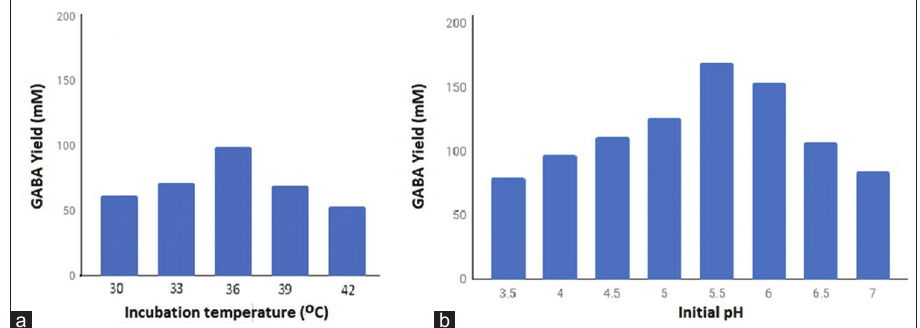
a Figure-2: Effect of incubation temperature (a) and initial pH of medium (b) on γ-aminobutyric acid production by Lactobacillus plantarum N5.